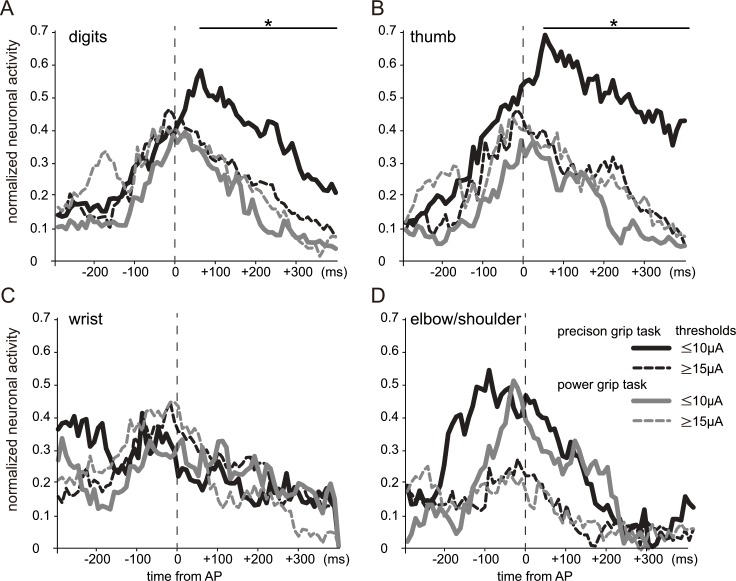
Normalized neuronal activity for both precision and power grip tasks, aligned to the time of approaching the target (AP), in each body representation in the primary motor cortex (M1).(A) Digit representation. (B) Thumb representation. (C) Wrist representation. (D) Elbow/shoulder representation. The neuronal firing rate was normalized by subtracting the baseline firing rate and then dividing the resulting value by the maximum level of activity observed across the two grasp types for all periods. The asterisks and lines at the top of the graphs indicate the bins in which the normalized activities of lower threshold (LT) neurons (located at recording sites with movement thresholds of 10 μA or less) for precision grasping were higher than those for power grasping (P < 0.001, Mann–Whitney U-test). In the digit representation, a significant difference in normalized neuronal activity was observed between precision and power gripping during the grasping phase, and the difference was greater when only neurons in the thumb representation were analyzed. LT neurons in the elbow/shoulder representation showed higher normalized neuronal activity than did HT neurons during the period just before grasping (–100 to 0 ms from AP) for both precision and power grip tasks (P < 0.01, Mann–Whitney U-test).